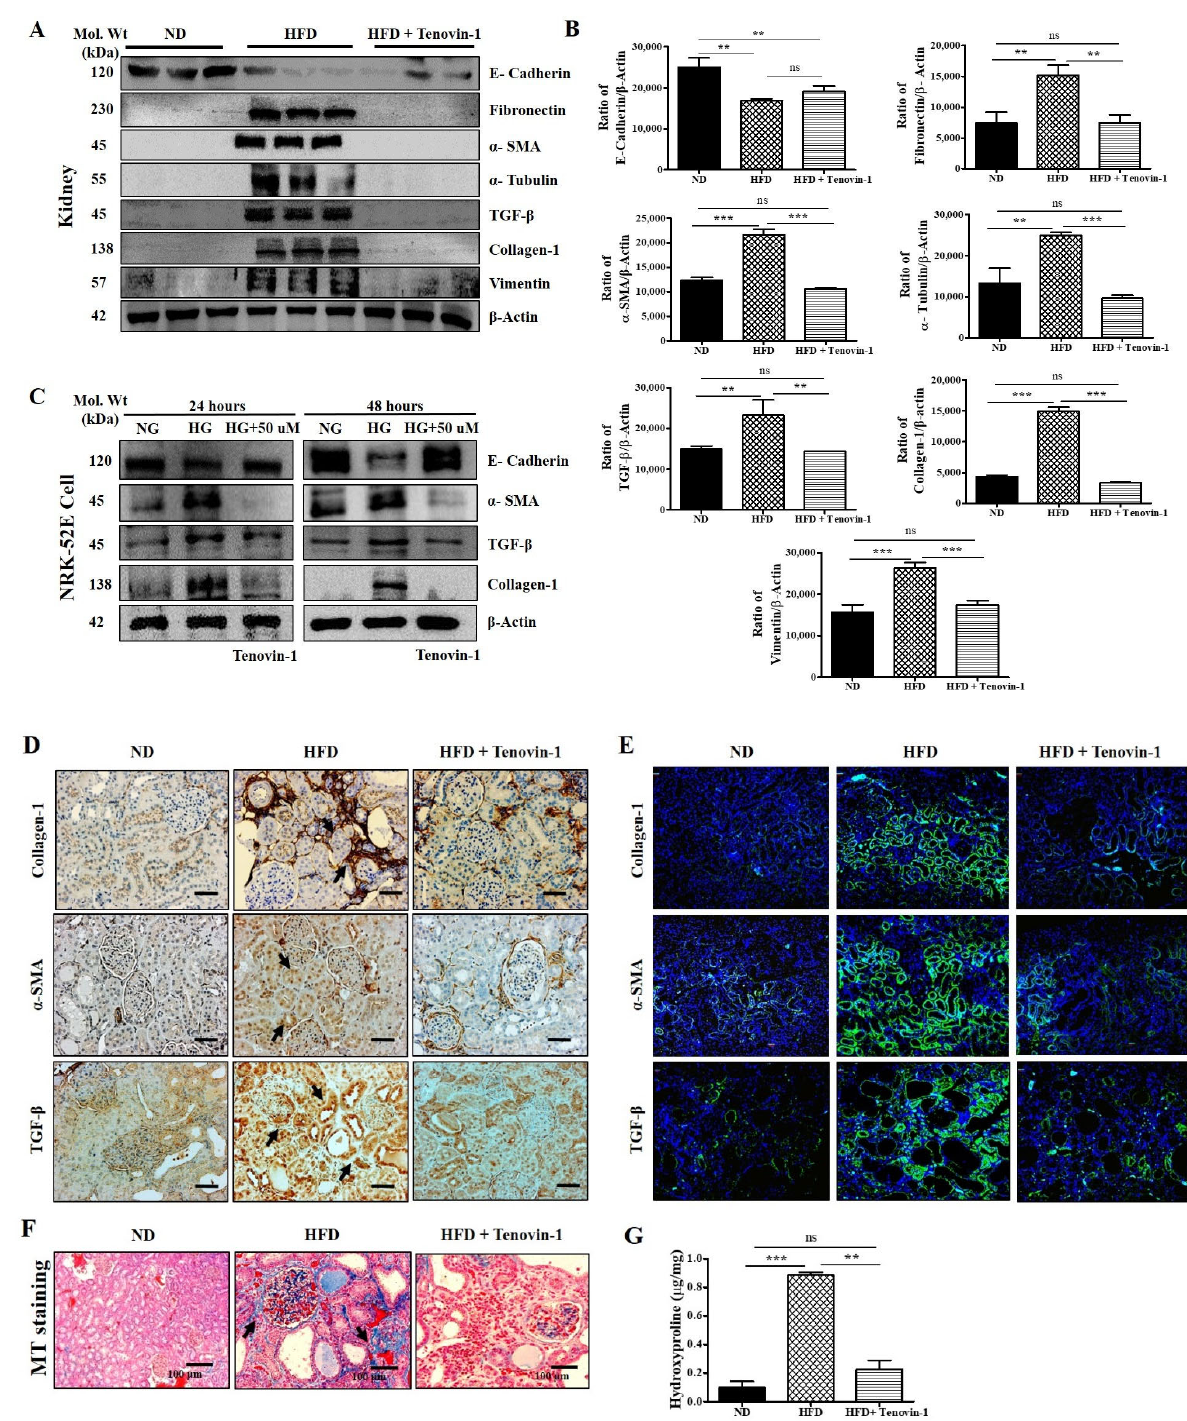
Figure 6. Effect of Tenovin ‐ 1 on renal fibrosis biomarkers in rats with HFD ‐ induced diabetes. ( A ) The levels of expression of E ‐ cadherin, fibronectin, α‐ SMA, α‐ tubulin, TGF ‐β , collagen ‐ 1, and vimentin were measured using Western blot analysis in experimental rat models of HFD ‐ induced diabetes. The graph for Western blot analysis represents the results obtained from three separate experimental outcomes. β‐ actin was used as the loading control. ( B ) The band intensities were quantified densitometrically using Image J software. ( C ) Western blot analysis of renal fibrosis biomarkers using the NRK ‐ 52E cell lysate. ( D ) Representative immunohistochemical analysis of